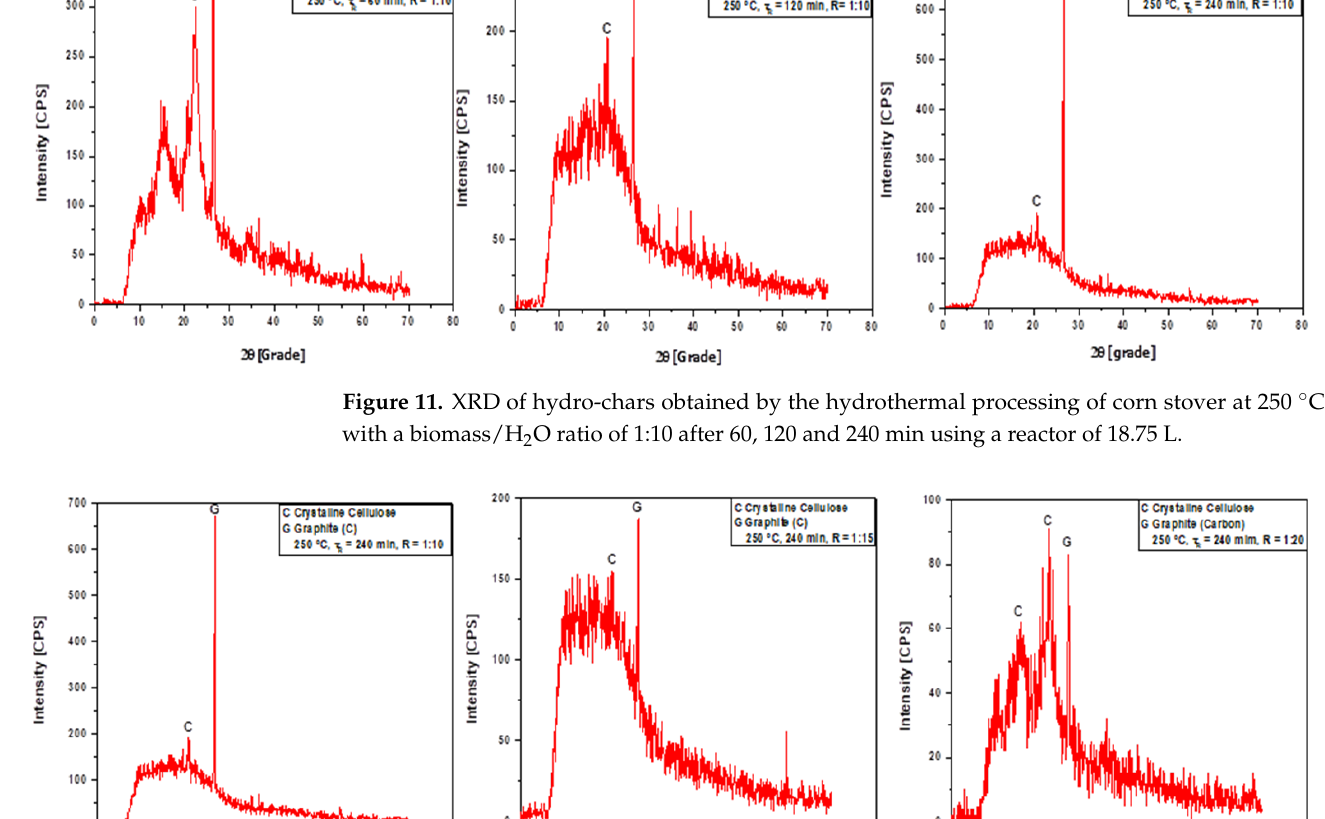
Figure 11. XRD of hydro-chars obtained by the hydrothermal processing of corn stover at 250 °C with a biomass/H 2 O ratio of 1:10 after 60, 120 and 240 min using a reactor of 18.75 L.